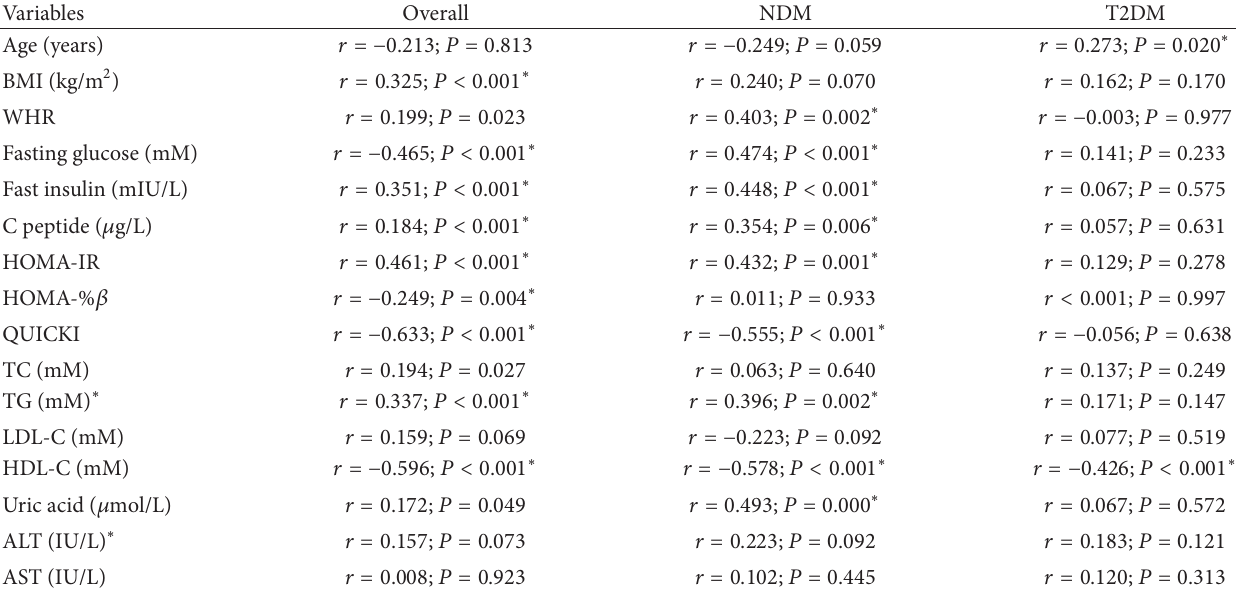
Table 2: Correlations between betatrophin levels and various parameters of the study subjects.